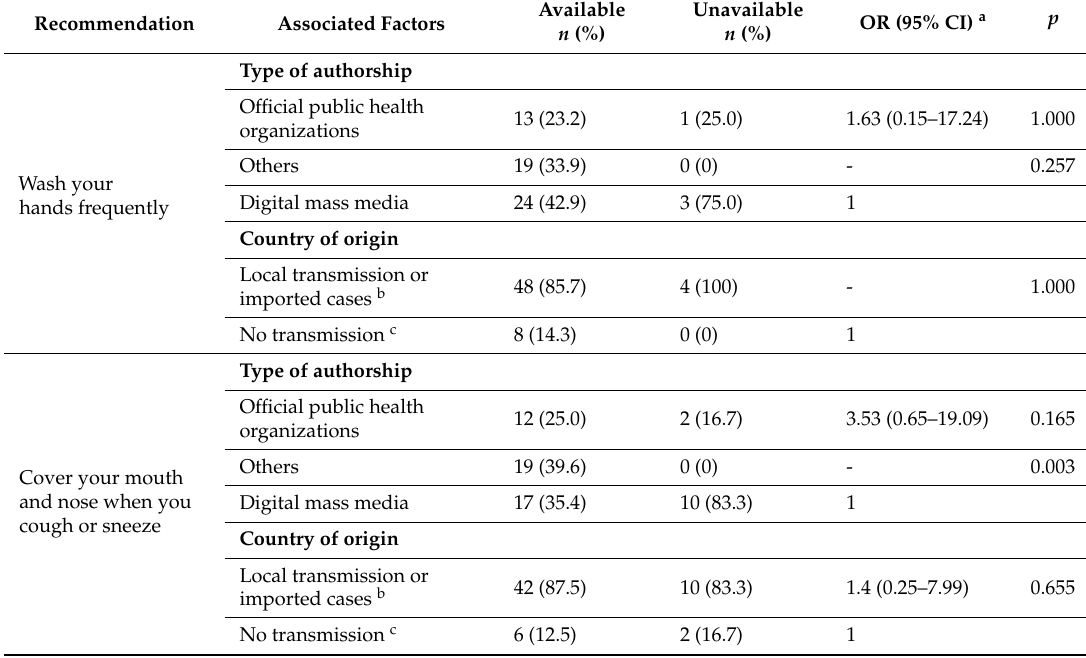
Table 3. Recommendations relating to the prevention of COVID-19 provided by the WHO and available on the Internet, with associated factors, on 1 March